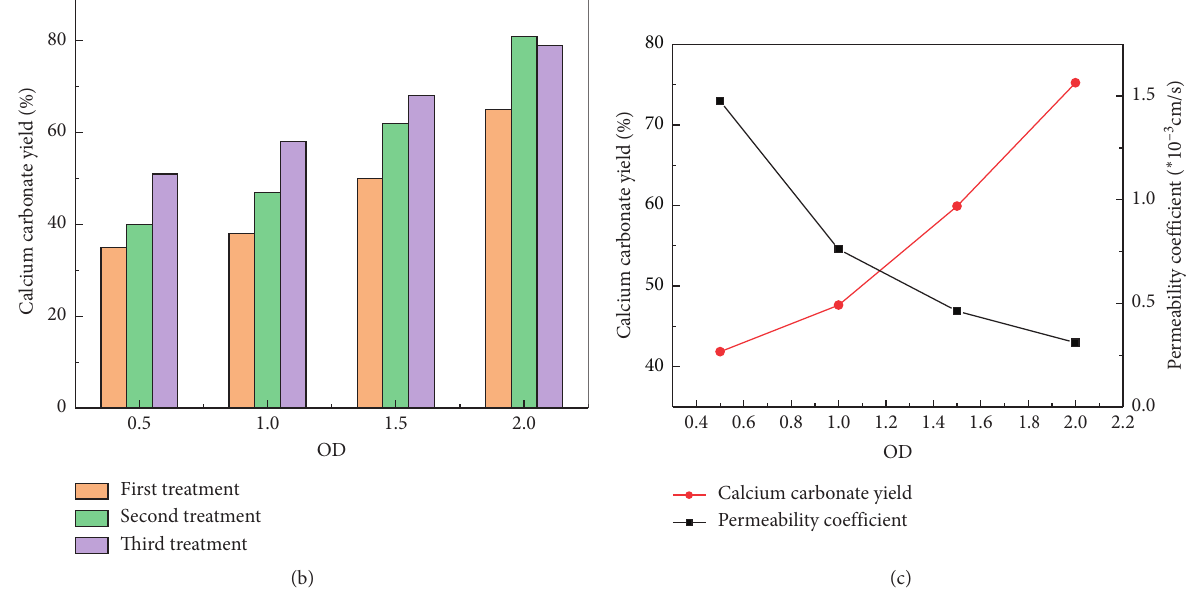
Figure 6: Filling effects of calcium carbonate with different bacterial concentrations. (a) Calcium carbonate filling process. (b) Change of calcium carbonate content. (c) Change of fracture